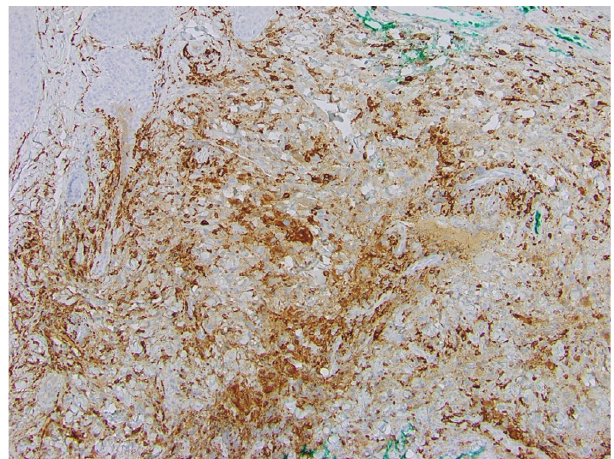
Figure 5: CD163 immunohistochemical study highlights the tissue macrophages. × 100 magni fi